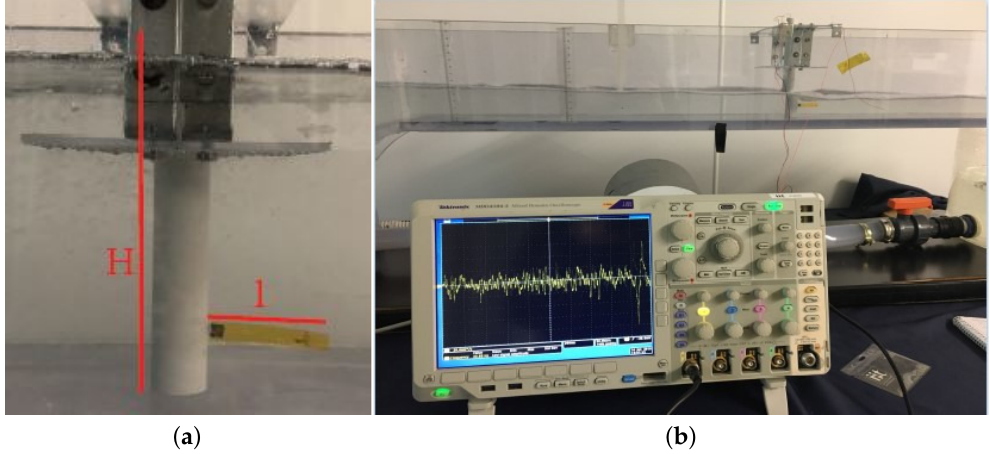
Figure 3. Flapping flag clamped at the cylinder ( a ) and Oscilloscope Tektronix MSO2000B ( b ). Several measurements were performed in order to find a constitutive law and all the stress–strain curves present the same shape, with an initial linear portion and then a non- linear region. These curves result from Dynamic Mechanical Analysis (DMA) of the AlN- based flexible flag. The Young’s modulus was determined as the slope of the first portion of the stress-strain curves and calculated as an average value of several measurements.